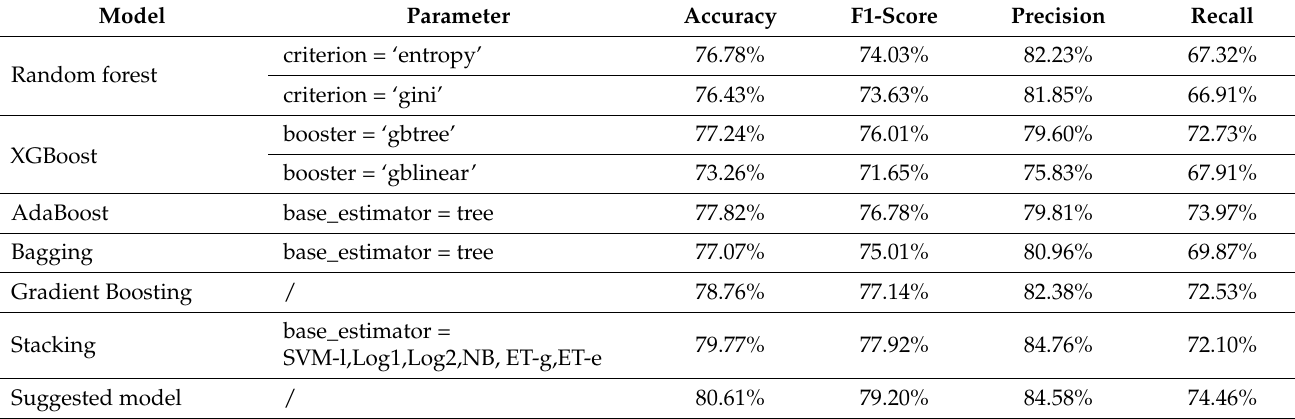
Table 6. Performance results of multiple ensemble